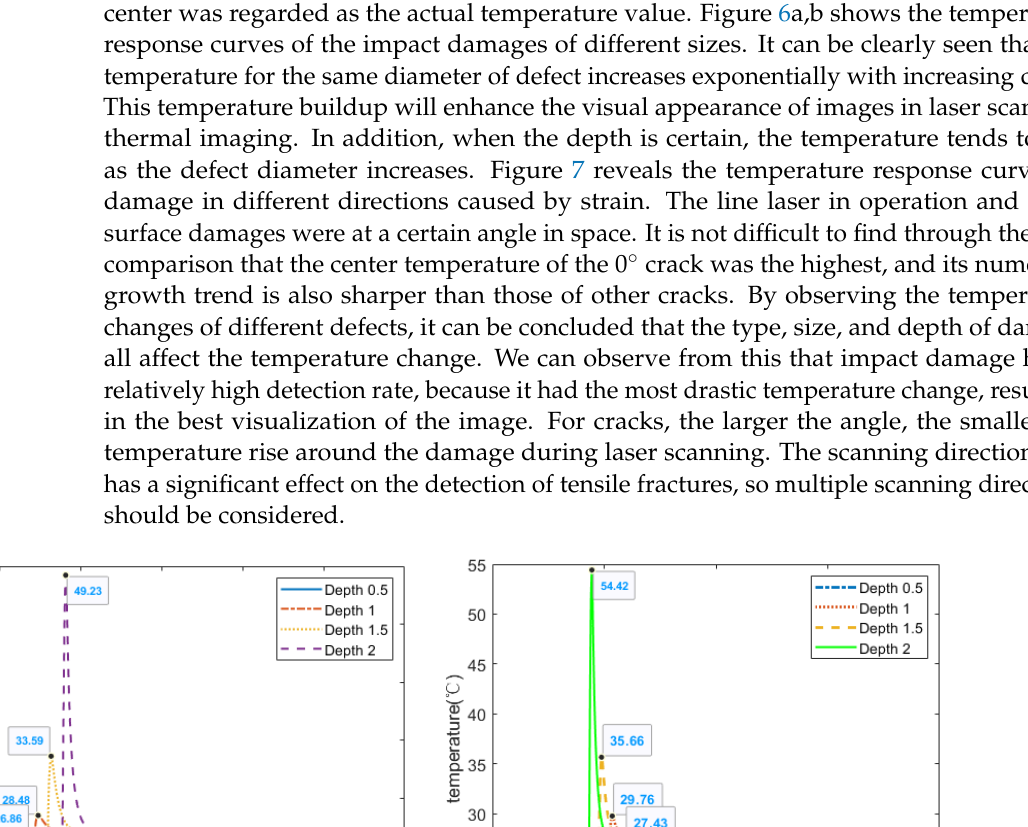
Figure 5. Heat conduction model of carbon ‐ fiber ‐ reinforced composite surface.